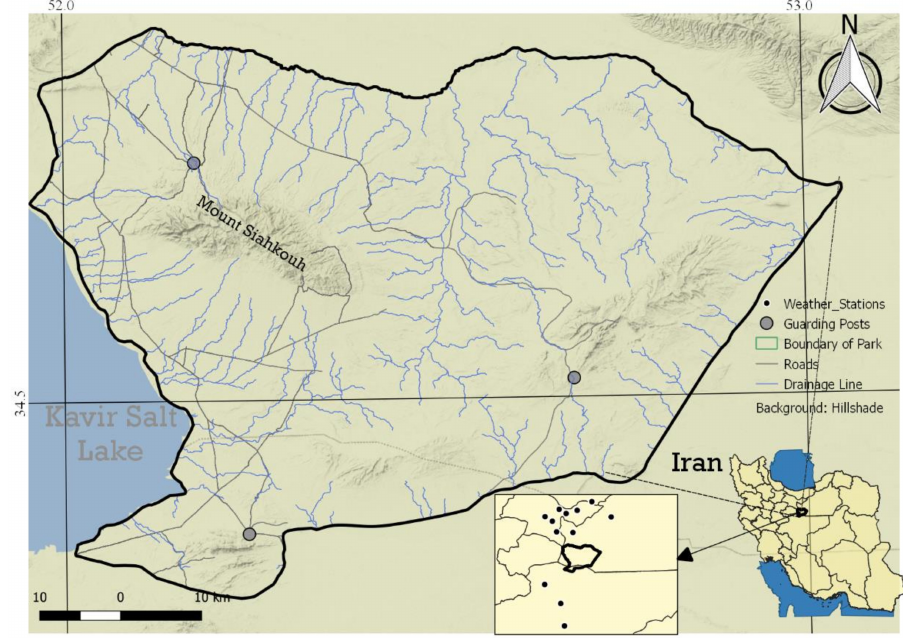
Figure 1. An overview map of the Kavir National Park in relation to Iran’s Boundary along with the location of weather stations in central part of